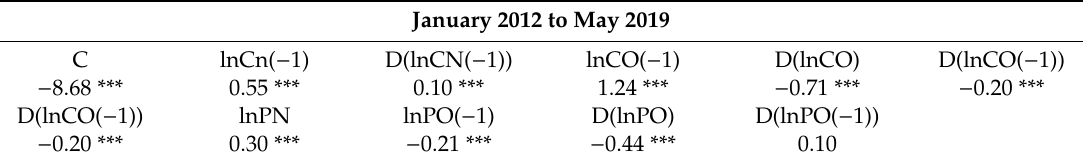
Table 10. ARDL long run form with the control